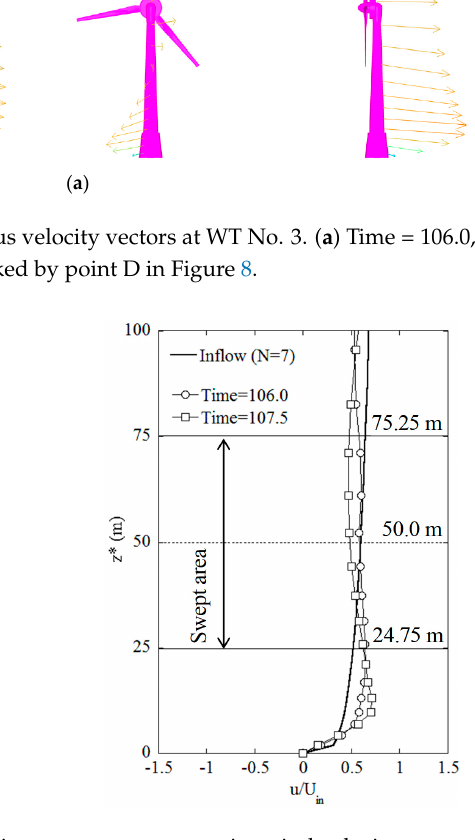
Figure 10. Profiles of instantaneous streamwise wind velocity corresponding to Figure 9 (WT